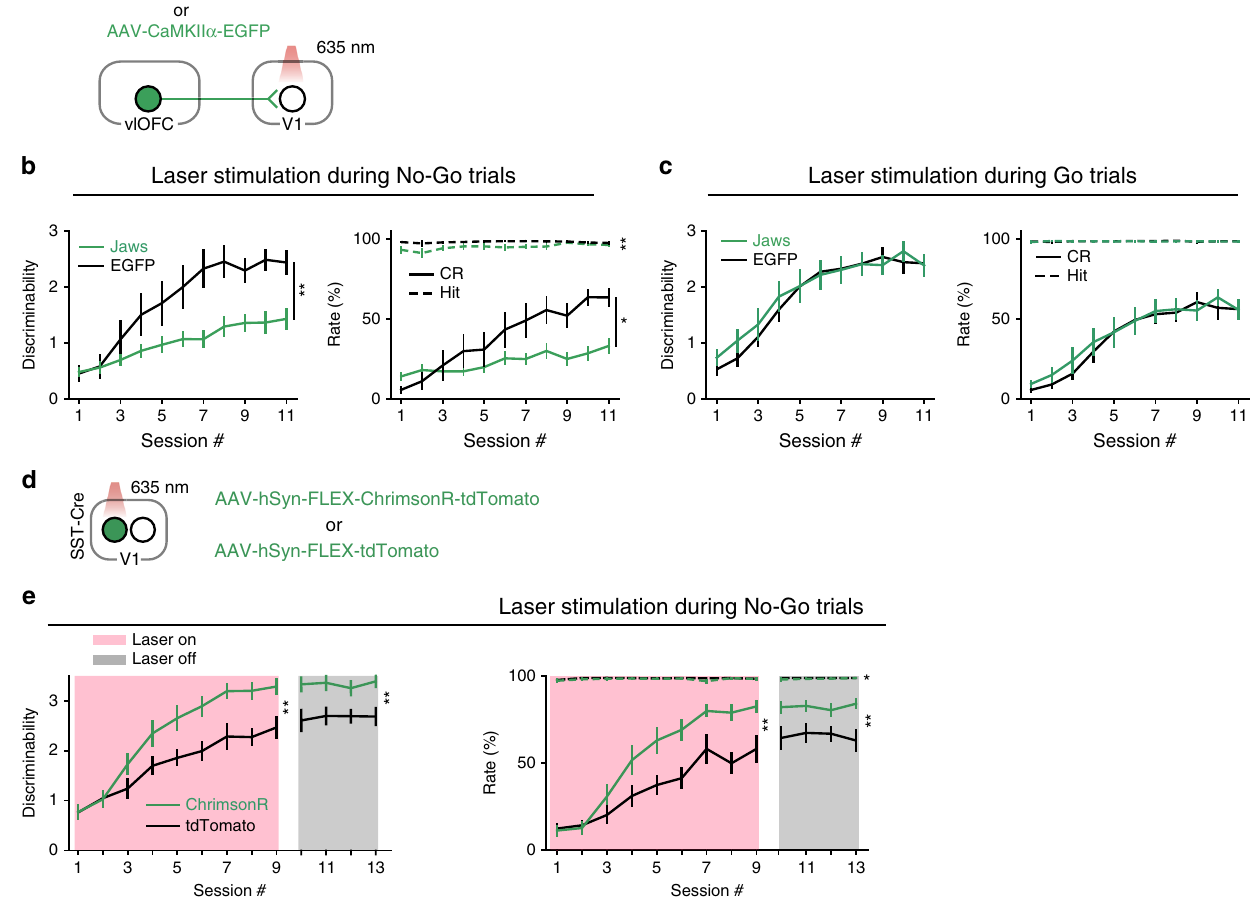
Fig. 6 OFC projection to V1 contributes to visual associative learning. a Schematic of the strategy for inactivating OFC projection to V1. b Effect of inactivating OFC projection to V1 during No – Go trials. n = 9 and 13 for EGFP- and Jaws-expressing mice, respectively. For discriminability: F (1,20) = 10.24, ** P = 0.004. For hit rate: F (1,20) = 13.38, ** P = 0.002. For CR rate: F (1,20) = 6.69, * P = 0.02. Two-way ANOVA with mixed design. c Effect of inactivating OFC projection to V1 during Go trials. n = 11 and 12 for EGFP- and Jaws-expressing mice, respectively. For discriminability: F (1,21) = 0.13, P = 0.72. For hit rate: F (1,21) = 0.24, P = 0.63. For CR rate: F (1,21) = 0.13, P = 0.72. Two-way ANOVA with mixed design. d Schematic of the strategy for activating SST interneurons in V1. e Effect of activating SST interneurons in V1 during No – Go trials. n = 10 and 11 for tdTomato- and ChrimsonR-expressing mice, respectively. Sessions 1 – 9, with laser stimulation; sessions 10 – 13, without laser stimulation. For discriminability in sessions 1 – 9: F (1,19) = 10.44, ** P = 0.004; discriminability in sessions 10 – 13: F (1,19) = 11.93, ** P = 0.003. For hit rate in sessions 1 – 9: F (1,19) = 4.37, P = 0.05; hit rate in sessions 10 – 13: F (1,19) = 6.07, * P = 0.02. For CR rate in sessions 1 – 9: F (1,19) = 10.63, ** P = 0.004; CR rate in sessions 10 – 13: F (1,19) = 9.84, ** P = 0.005. Two-way ANOVA with mixed design. For b , c , e , source data are provided as a Source Data fi le. Error bars, mean ±